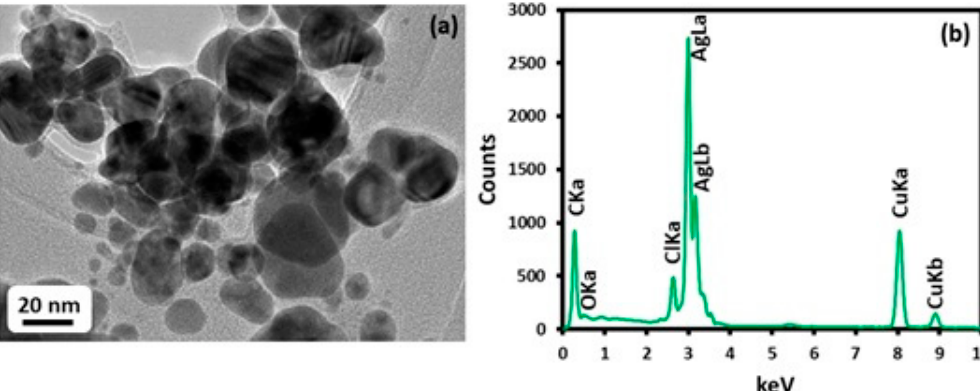
Figure 4. ( a ) high resolution transmission electron microscopy (HRTEM) image of the green synthesized silver nanoparticles (Ag-MC), and ( b ) energy dispersive X-ray spectroscopy of Ag-MC.